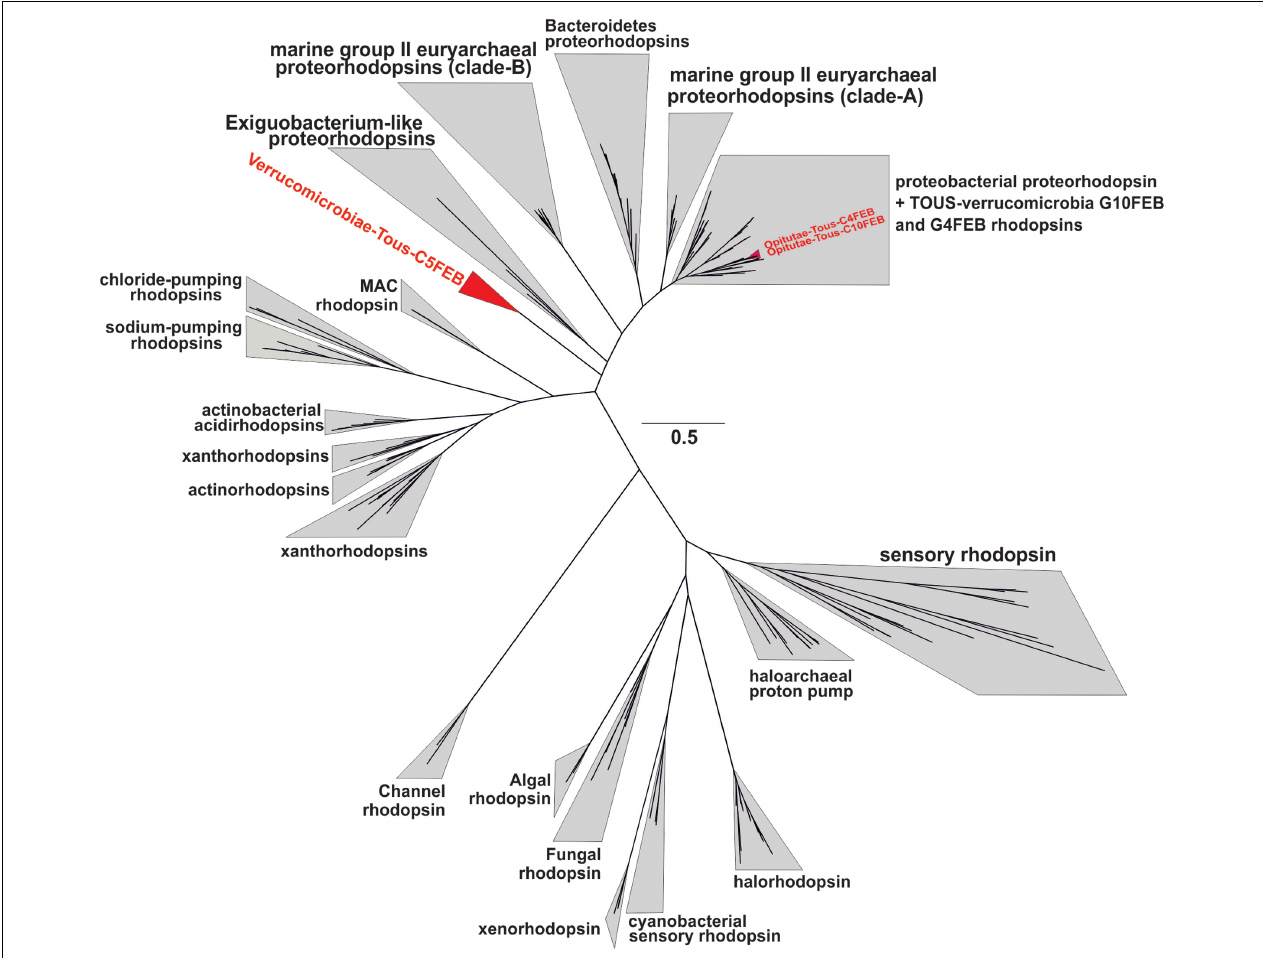
FIGURE 7 | Phylogenetic placement of the three Tous freshwater verrucomicrobial rhodopsins together with a batch of 200 rhodopsin references from different types and multiple origin (marine, brackish, freshwater, or